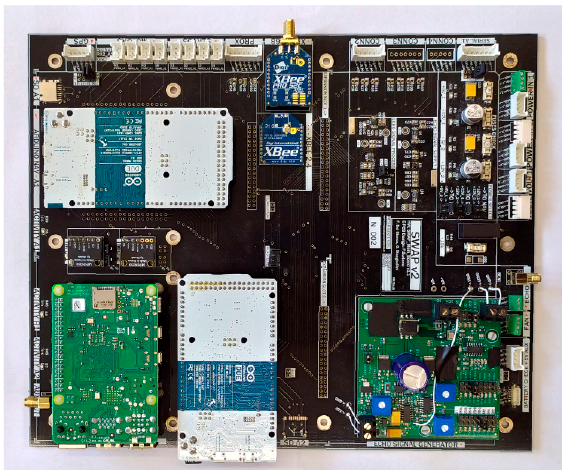
Figure 4. Block-diagram ( top ) and photo ( bottom ) of the OpenSWAP mainboard.